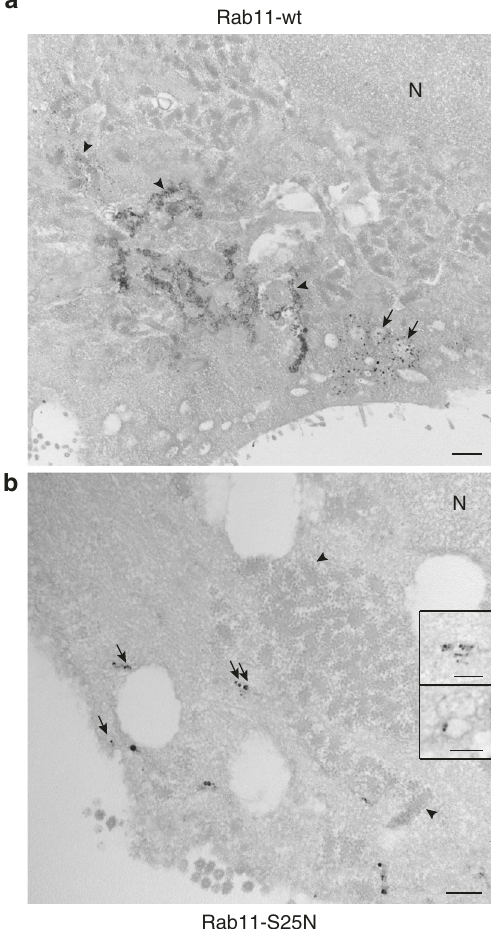
Fig. 6 Ultrastructural localization of HA-MT-Rab11 and HA-MT-Rab11-S25N by METTEM upon IAV infection. a Distribution of stably expressed HA- MT-Rab11 in WSN-infected A549 cells at 8 hpi. Cells were incubated with gold and silver before processing. Signals reveal the location of HA-MT- Rab11 in remodeled ER (arrowheads) and ICVs (arrows). N, nucleus. b Distribution of stably expressed HA-MT-Rab11-S25N in WSN-infected A549 cells at 8 hpi. Signals show the presence of HA-MT-Rab11-S25N in small vesicles (arrows). The arrowheads label remodeled ER with groups of ribosomes. No ICVs are detected. Insets are enlargements of labeled vesicles. The inset on the top corresponds to the vesicle marked with a double arrow in the middle of the main fi eld. After irradiation in the microscope the silver particles decrease in size and the electron lucent center of the vesicle is better seen. The inset on the bottom corresponds to a labeled vesicle from another cell. Scale bars, 0.5 μ m a ; 200 nm b . 100 nm